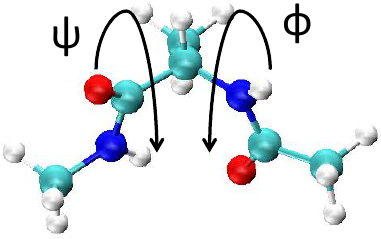
Figure 5. The structure of the alanine dipeptide we examined. The torsion angles, φ and ψ, that are used for the reaction coordinate are also shown.